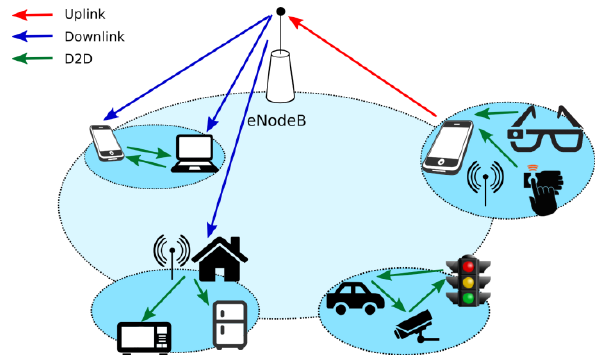
Figure 1. D2D communications in 5G IoT